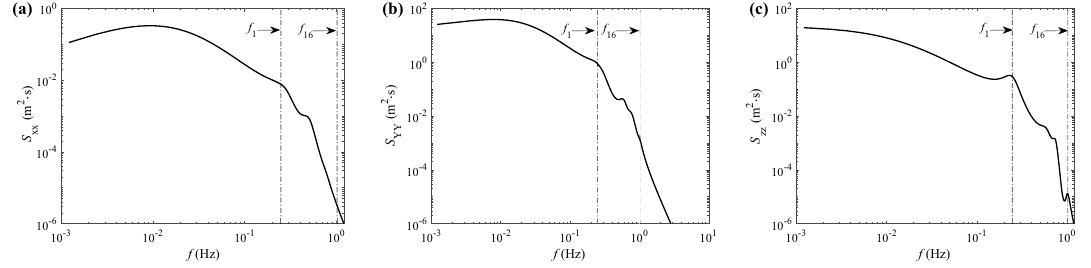
Figure 11. PSDs of displacement response components at mid-span point ( V 10 = 45 m/s): ( a ) longitudinal displacement; ( b ) alongwind displacement; ( c ) crosswind displacement.